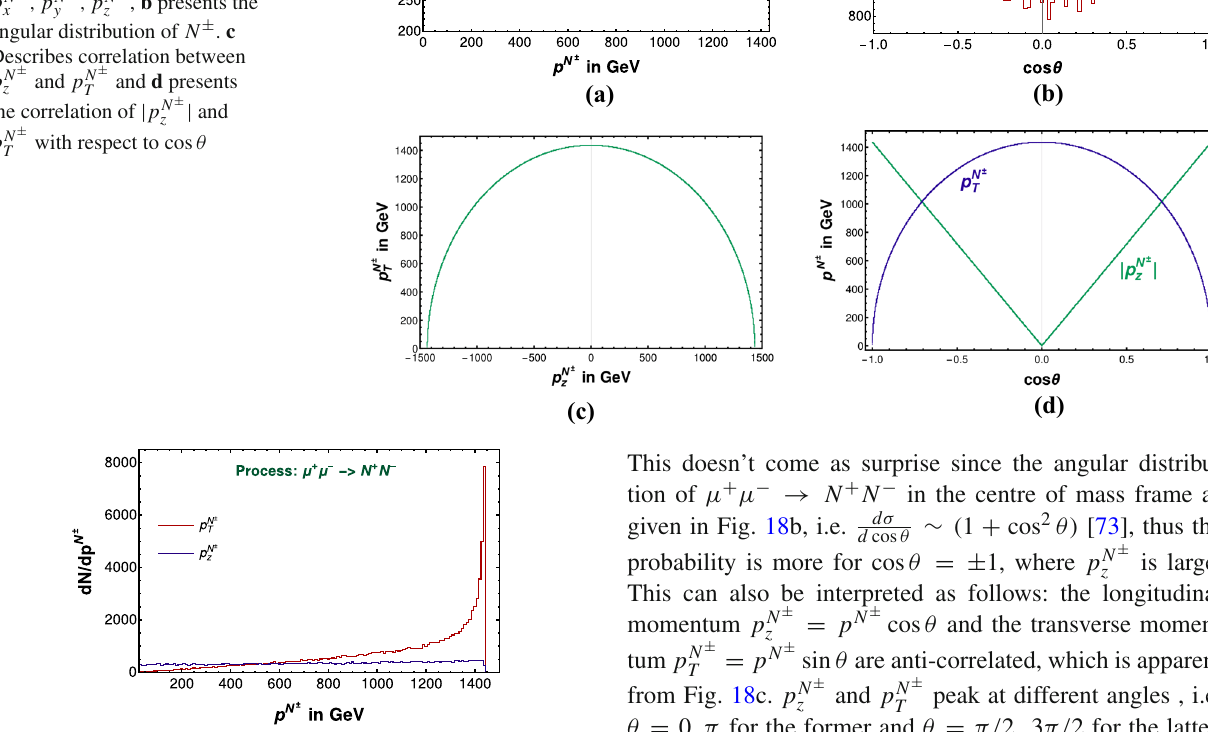
Fig. 18 Various correlations of longitudinal ( p N ± z ) and transverse ( p N ± ) momenta of T N ± at muon collider with centre of mass energy of 3.5 TeV for BP1 for the process of μ + μ − → N + N − . a Describes p N ± x , p N ± y , p N ± z , b presents the angular distribution of N ± . c Describes correlation between p N ± z and p N ± and d presents T the correlation of | p N ± z | and